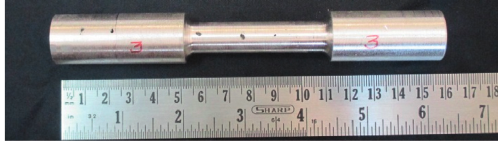
Figure 6: Tensile test sample.